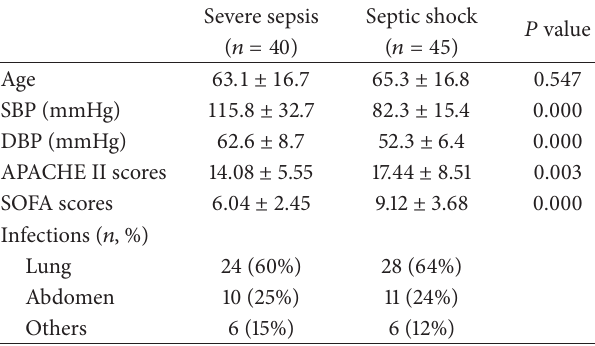
Table 1: Demographic characteristics of patients with severe sepsis and septic